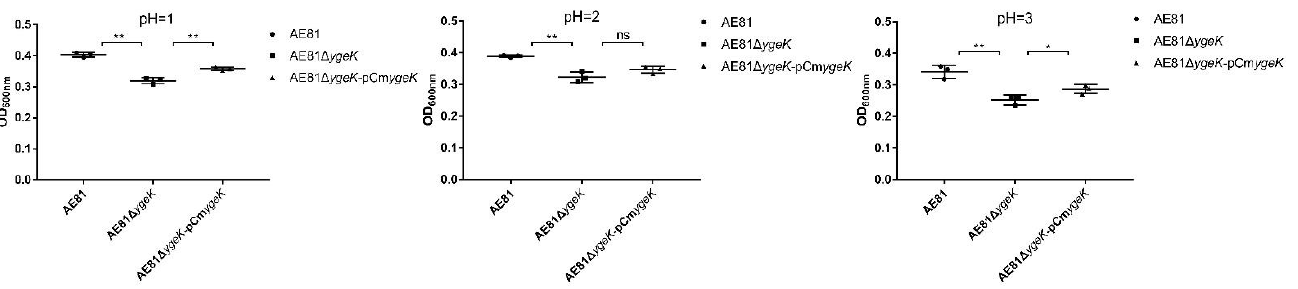
Figure 4. AE81, AE81Δ ygeK, and AE81Δ ygeK- p CmygeK resistance to different pH values (pH = 1.0, 2.0, 3.0). Values are average of three independent experiments (* p < 0.05, ** p < 0.01, ns: no signifi- cance).